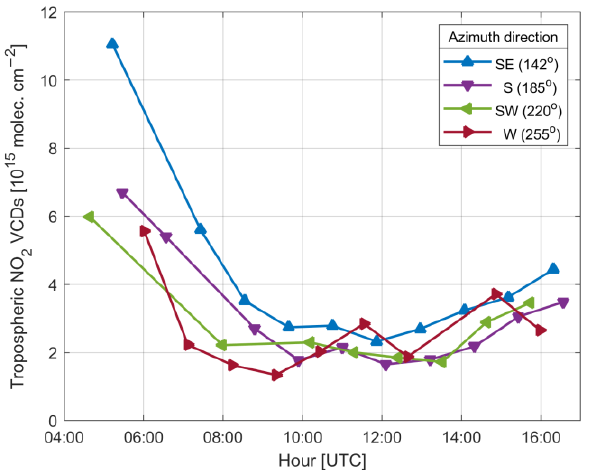
Figure 6. An example of the NO 2 VCDs diurnal variability for all azimuth viewing directions of the MAX-DOAS during a clear-sky summer day (30 July 2022).